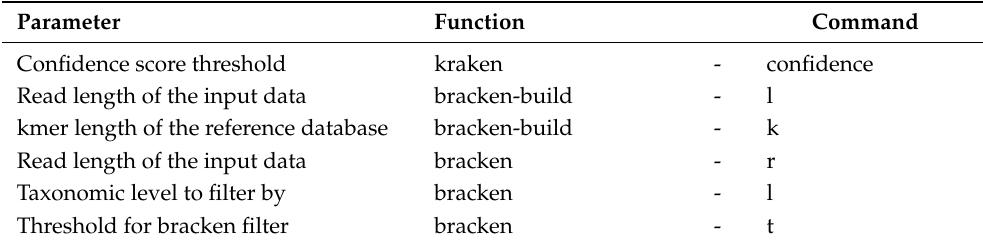
Table 2. Modifiable parameters of our Kraken/Bracken pipeline.